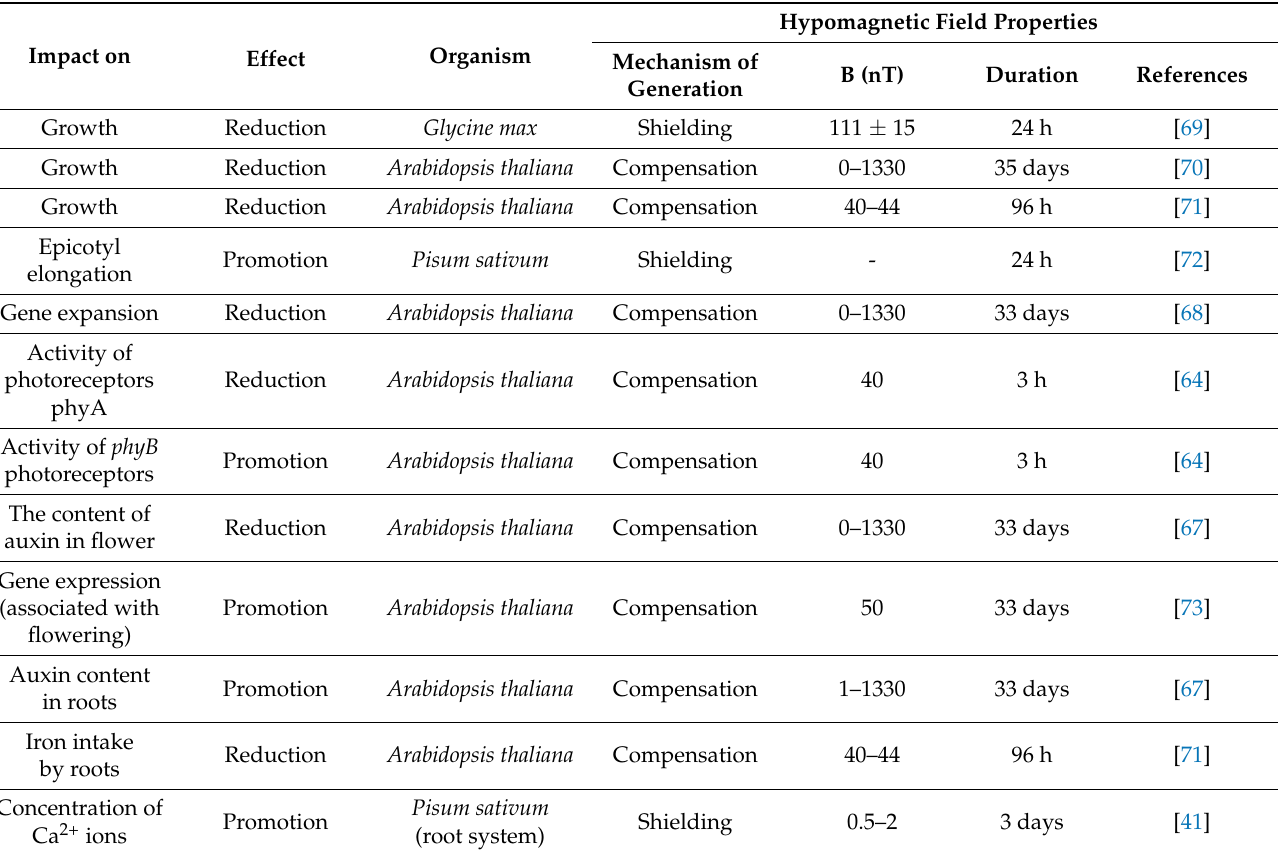
Table 3. Impact of hypomagnetic field on plants (B—magnetic flux density in Tesla